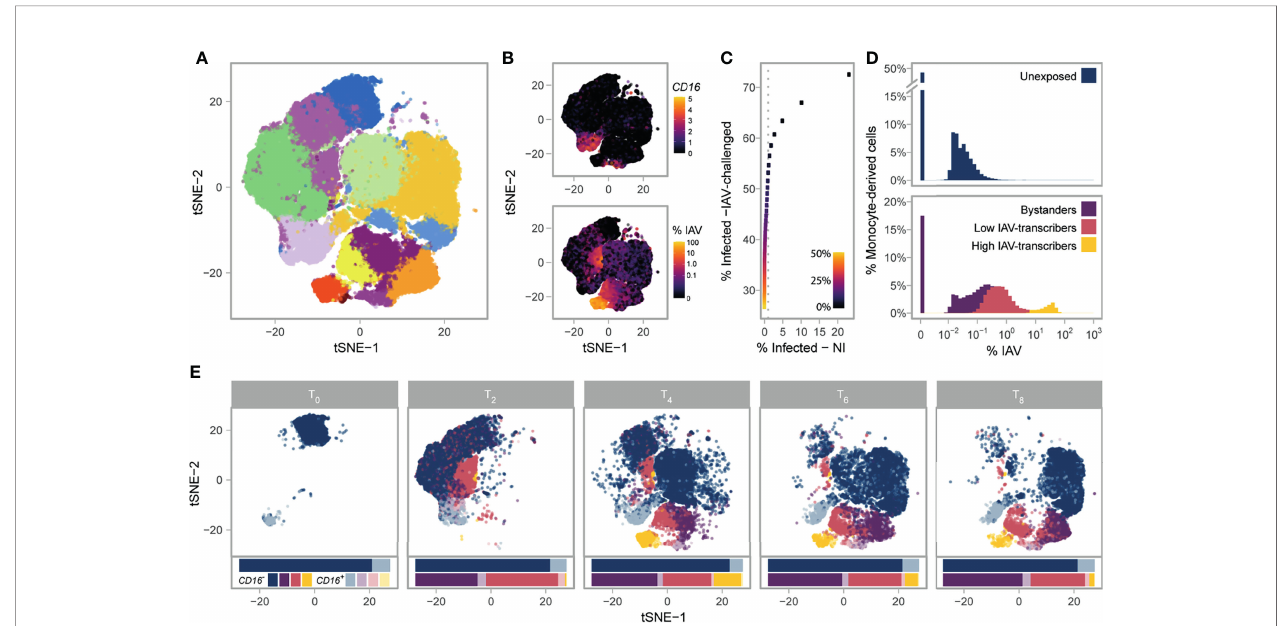
FIGURE 1 | Single-cell RNA-sequencing of 88,559 monocytes and their derived cells. (A) Post-QC tSNE colored by unsupervised graph-based clusters. (B) Post- QC tSNE colored by FCGR3A ( CD16 ) log 2 normalized counts (top), or percentage of viral mRNAs (bottom). (C) Determination of the maximum contamination fraction by ambient RNA. The number of non-infected cells deemed to signi fi cantly express IAV transcripts (presumed false positives) versus the number of IAV-challenged cells deemed to signi fi cantly express IAV transcripts across a range of maximum contamination fractions from 1-50% (color bar). Dotted grey line is drawn at 1% on the x-axis. A maximum contamination fraction of 10% results in 1% of non-infected cells being classi fi ed as infected (false positive proxy), and half of IAV-challenged cells showing evidence of viral transcription. (D) Distribution of counts of viral origin across all donors, from T 2 to T 8 . Cells are shown separately for non-infected (top) and IAV-challenged (bottom) conditions. Fill color re fl ects the cell state assignments. Note that the threshold used to de fi ne infected cells is dependent on the number of viral mRNAs in the ambient pool, and varies across libraries. (E) Post-QC tSNE strati fi ed by time point. For each time point, cells are colored according to their CD16 +/- status (see key) and their assigned cell state (same as depicted in D). For each condition and time point, stacked bar charts below the tSNE represent the relative proportions of the various cell states and subsets. IAV, In fl uenza A virus; NI, non-infected; tSNE, t-distributed Stochastic Neighbor